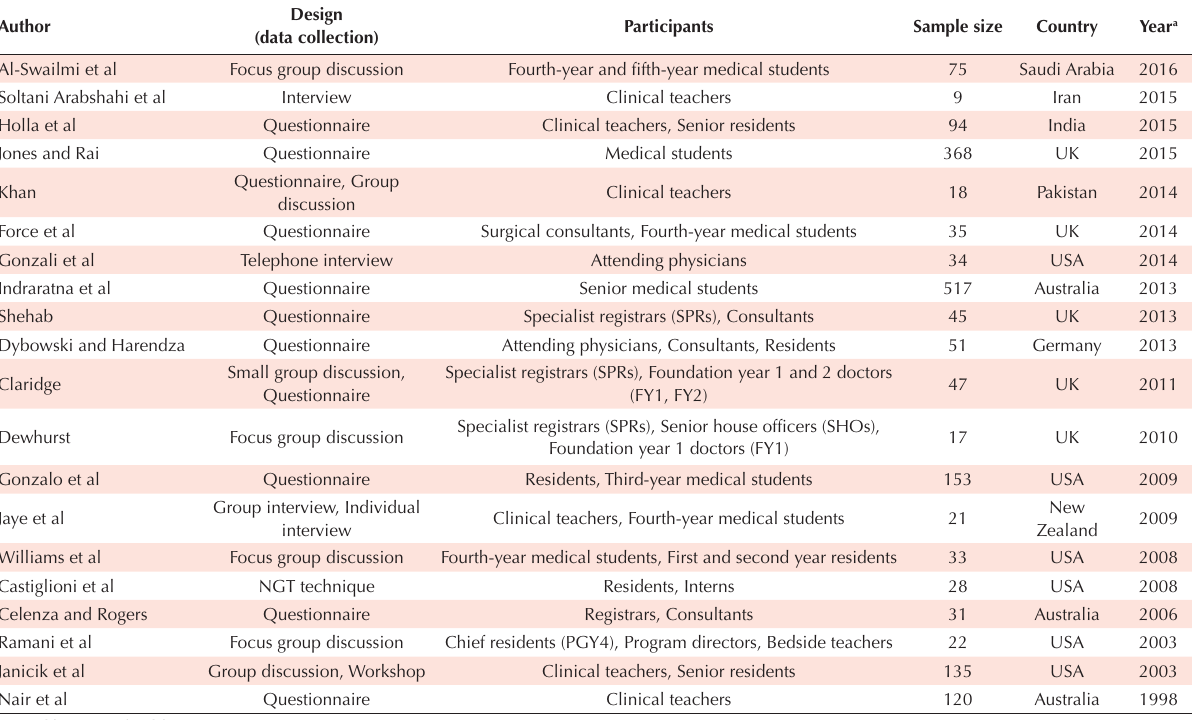
Table 2. Summary of included studies identifying the barriers to clinical rounds